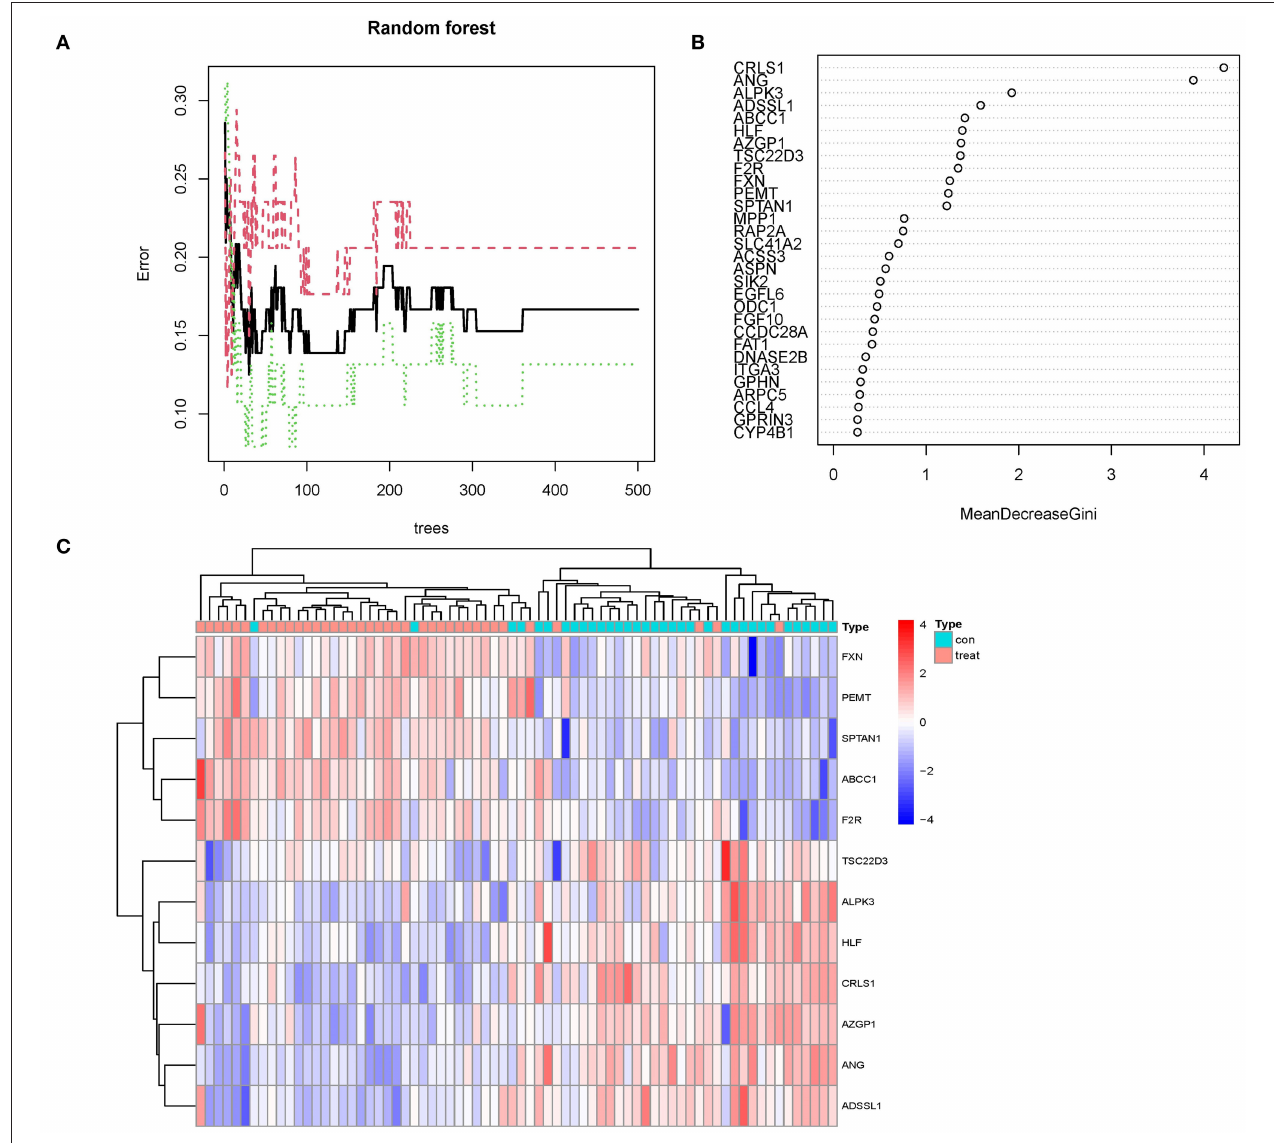
FIGURE 5 | (A) The mistake rate is influenced by the number of selection trees. The amount of decision trees is shown on the x- axis, while the mistake rate is represented on the y -axis. (B) Random forest classifier results using the Gini coefficient approach. (C) Unsupervised clustering heatmap demonstrating the hierarchical clustering formed by the twelve significant genes created by the random forest in the GSE24881 and GSE25403 merging dataset. The red band on the upper portion of the heatmap suggests normal samples, while the blue band indicates obesity disorder samples. Red color demonstrates genes with elevated expression in the samples, the blue color implies genes with low or undetectable in the